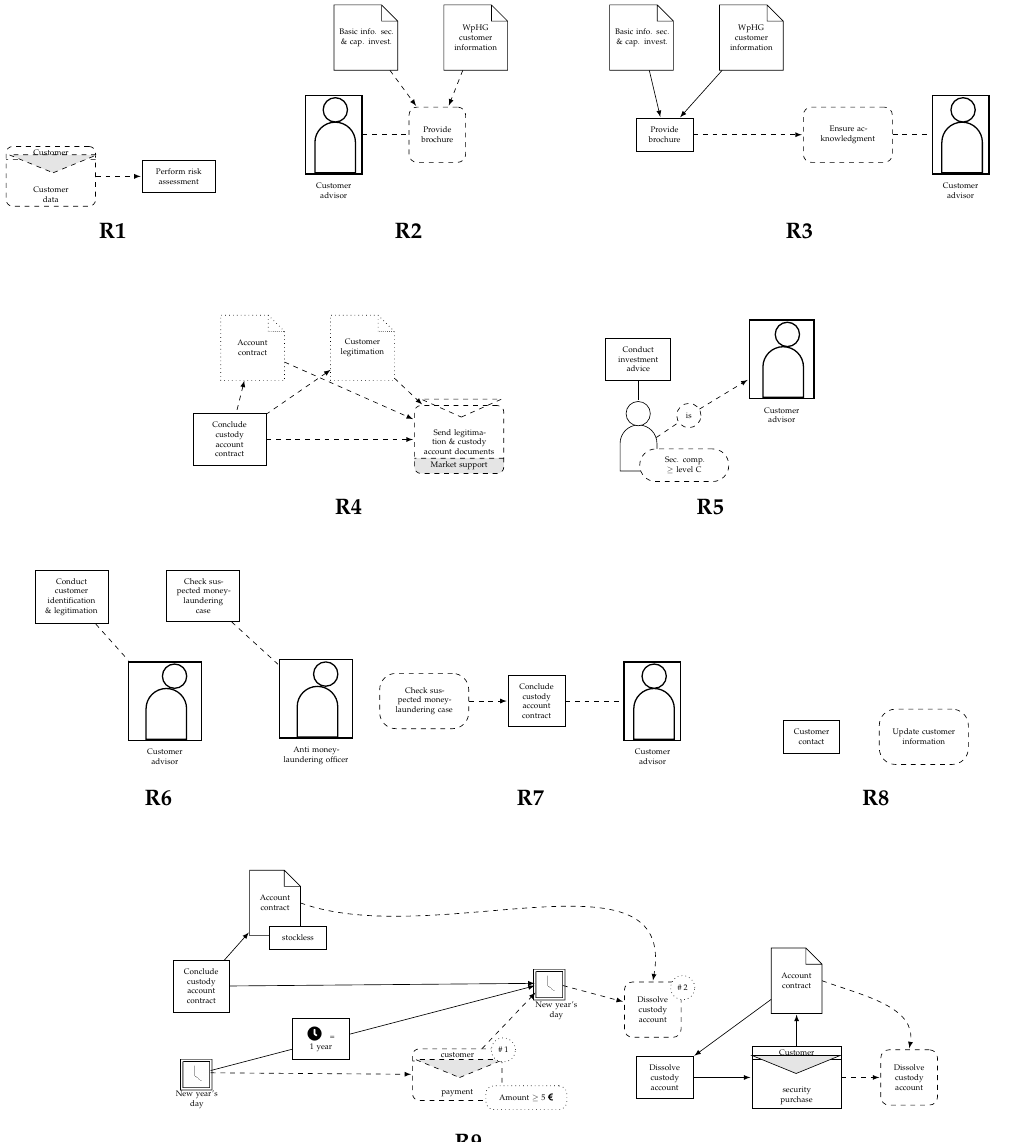
Figure 7. Formalised requirements in eCRG